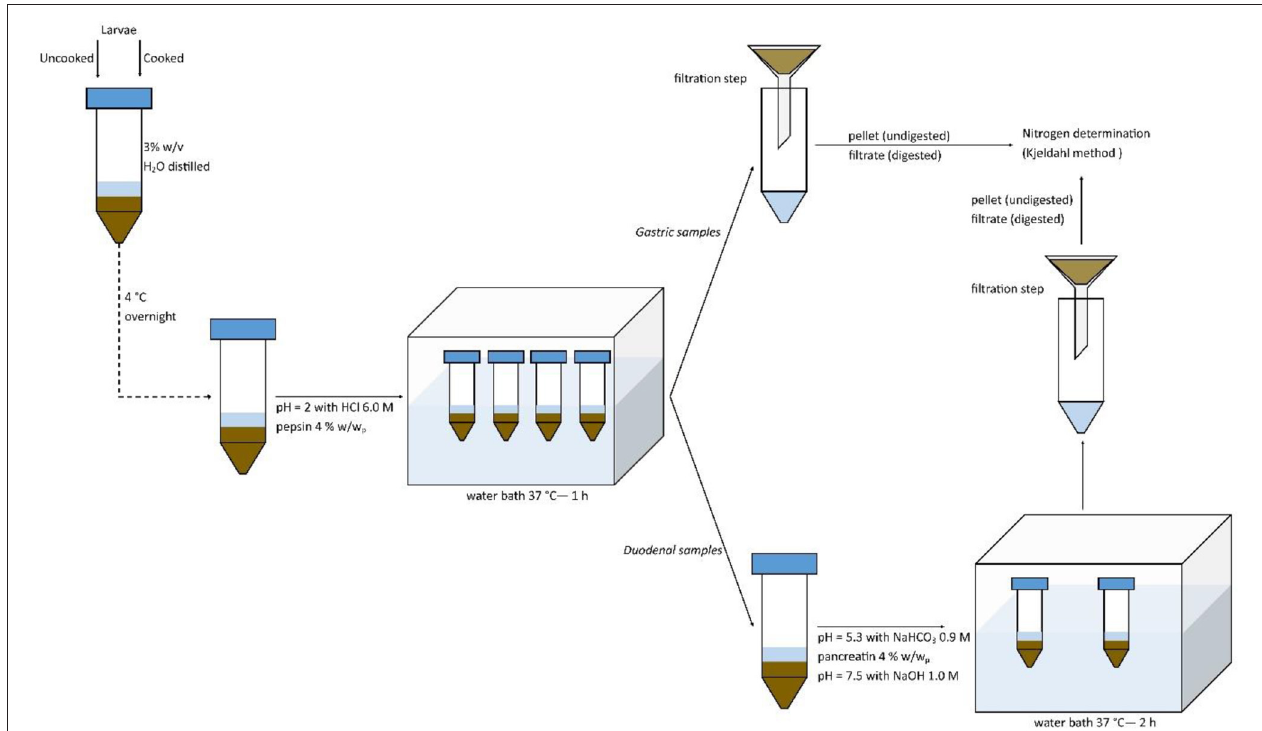
FIGURE 1 | In vitro protein digestibility method.